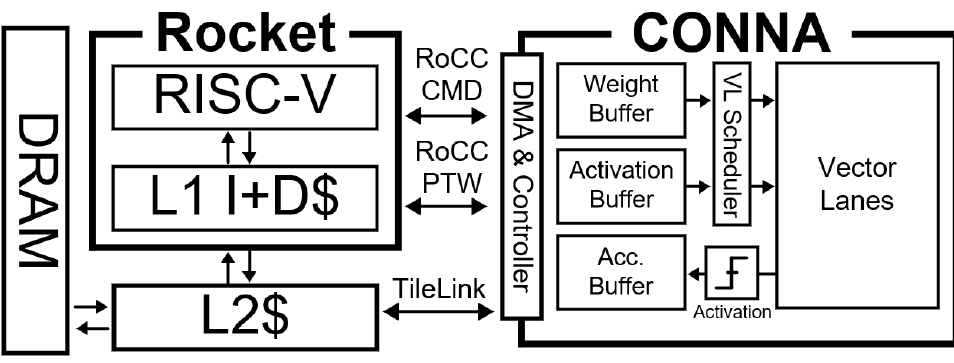
Figure 13. Block diagram of CONNA SoC.